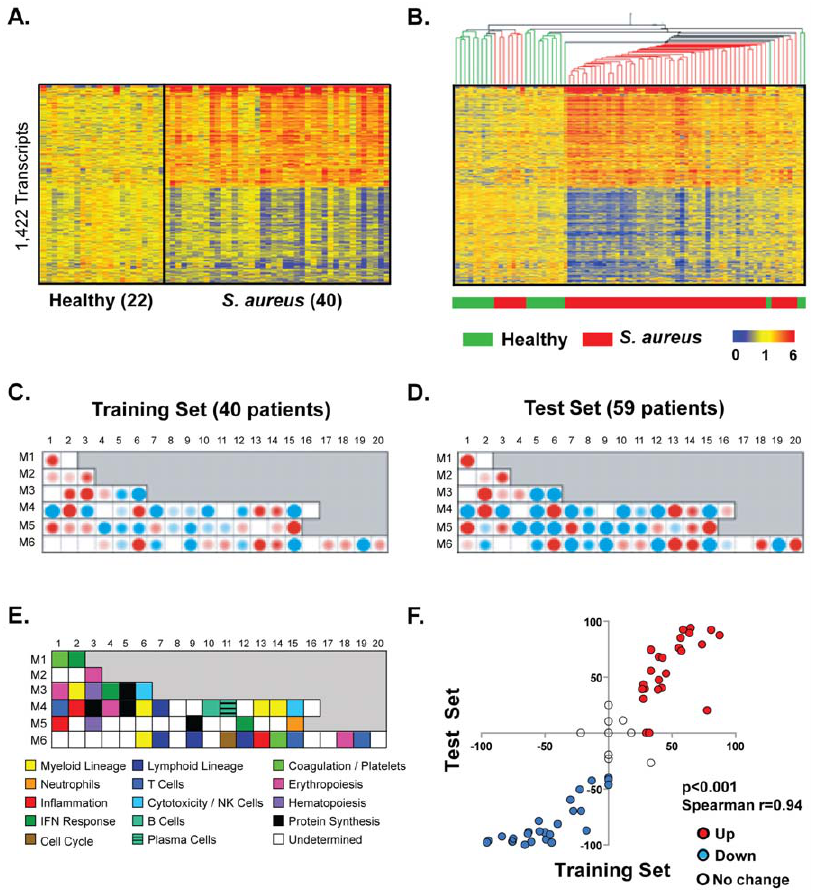
Figure 1. The S.aureus infection whole blood transcriptional signature is characterized by over-expression of myeloid lineage transcripts and under-expression of lymphoid lineage transcripts. A. Statistical group comparison between 22 healthy subjects and 40 patients with acute S. aureus infection (non-parametric test, a =0.01, Benjamini-Hochberg multiple testing correction, 1.25 fold change) yielded 1,422 differentially expressed transcripts. Transcripts were organized by hierarchical clustering (Spearman) according to similarities in expression profiles. Each row represents a transcript and each column an individual subject. Normalized log ratio levels are indicated by red (over-expressed) or blue (under-expressed), as compared to the median of healthy controls. B. The same 1,422 transcript list and hierarchical clustering were applied to an independent test set of 22 healthy controls and 59 patients with acute S. aureus infection. Sample hierarchical clustering (Spearman) was performed on the 1,422 transcript list in the test set. C. Average modular transcriptional fingerprrint for S. aureus patients as compared to healthy controls in the training set. D. Average modular transcriptional profile for S. aureus patients as compared to healthy controls in the test set. E. Module functional annotations legend. F. Scatter plot comparing module expression between training (x-axis) and test (y-axis) sets. Spearman correlation was applied.